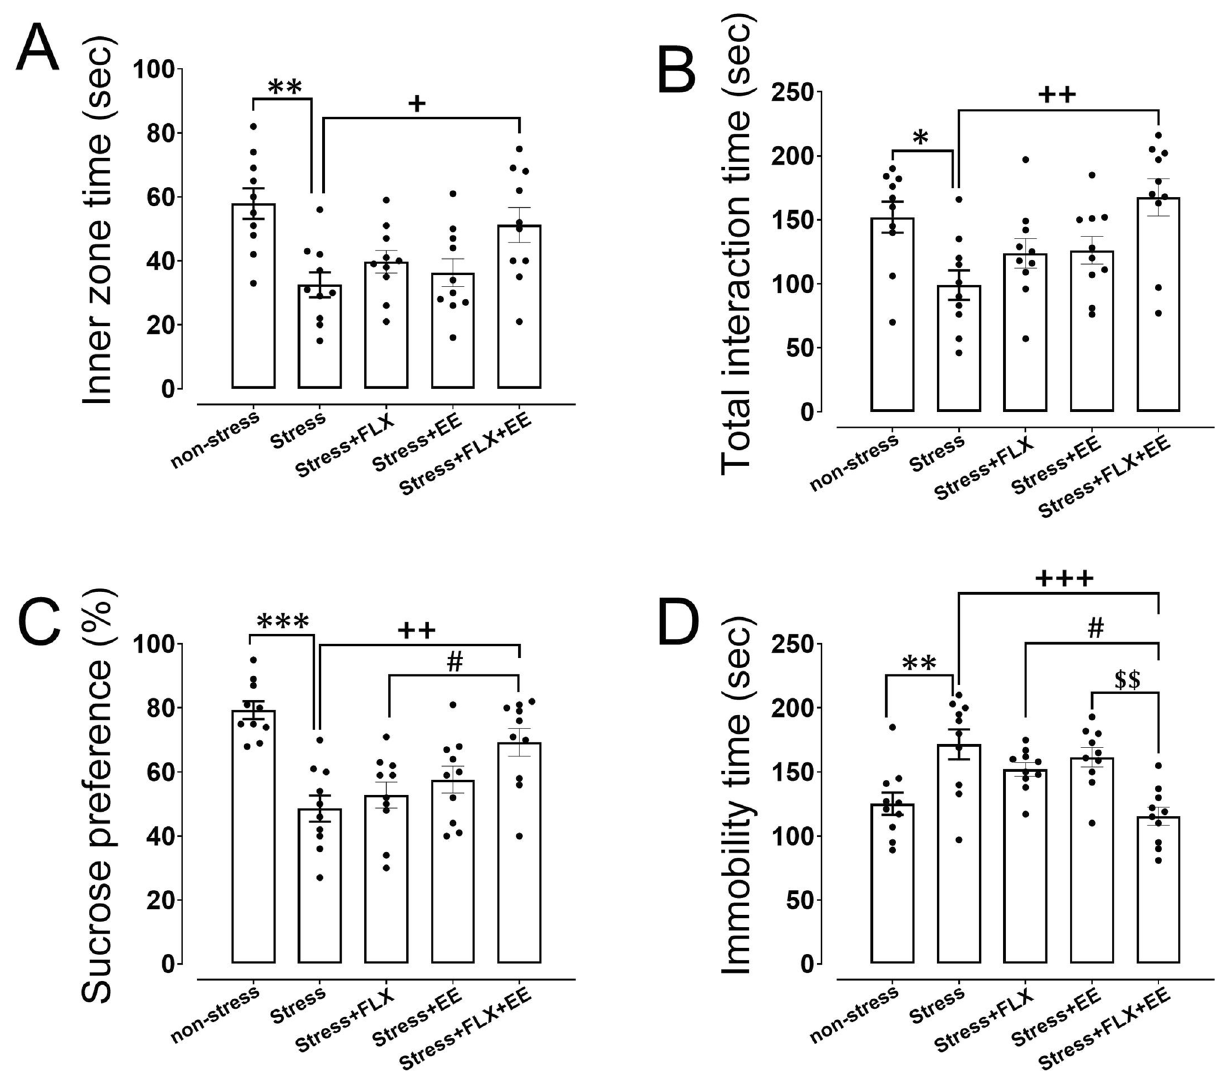
Figure 1. The effects of gestational stress, fluoxetine (FLX) treatment and environmental enrichment on anxiety-like behavior in the open field test (A; inner zone time) and depression-like behavior in the social interaction (B; total interaction time), sucrose preference (C), and forced swim test (D; immobility time) during the postpartum period in dams. Values are presented as mean ± SEM (N = 10). Significant differences: * P < 0.05, ** P < 0.01 and *** P < 0.001, compared to non-stress group; + P < 0.05, + + P < 0.01 and + + + P < 0.001, compared to stress group; # P < 0.05, compared to stress + FLX group; $$ P < 0.01, compared to stress + EE